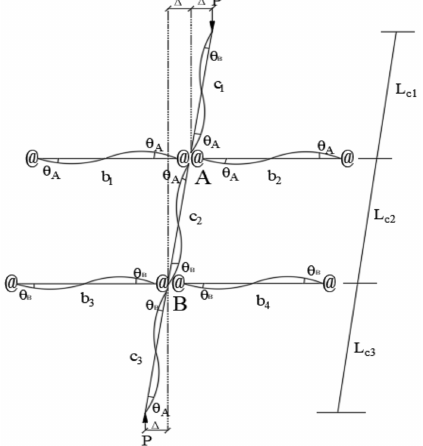
Figure 4. Three-layer frame model with lateral